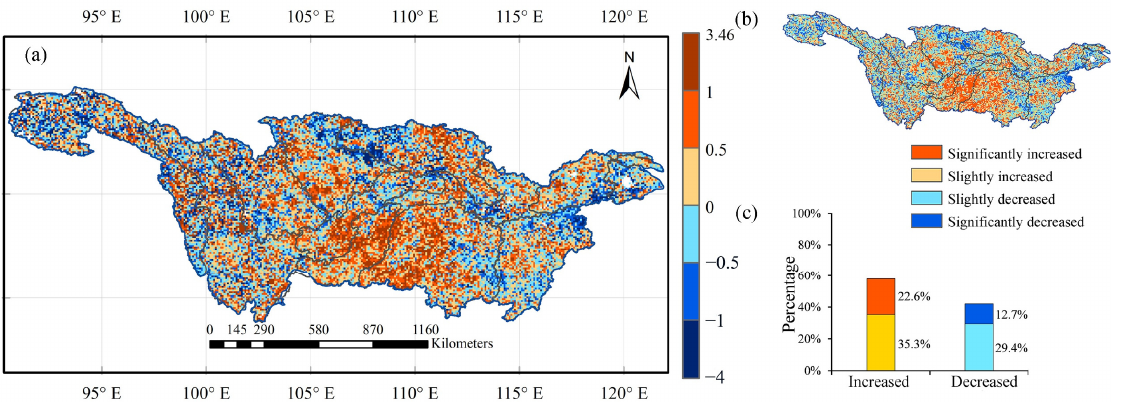
Figure 5. Contribution of climate variables to the VSI in the YZRB: ( a ) precipitation (PRE), ( b ) temperature (TEM), ( c ) solar radiation (RAD), and ( d ) the primary drivers controlling the VSI. The VSI time series were calculated by using a 15-year moving window approach, and the spatial distributions of the variability in the VSI are displayed in Figure 6. The VSI trends in the YZRB ranged from − 4 to 3.46, and most of the areas fluctuated between − 1 and 1. Based on the Mann–Kendall test, the VSI trends were classified into four types: significantly increased, slightly increased, significantly decreased, and slightly decreased. The percentages of increasing and decreasing VSIs in the YZRB were 57.9% and 42.1%, respectively. The areas with significantly increased VSI trends accounted for 22.6% and were mainly concentrated in the south-central part of the YZRB, while only 12.7% of the areas had significantly decreased VSI trends and were sporadically distributed.